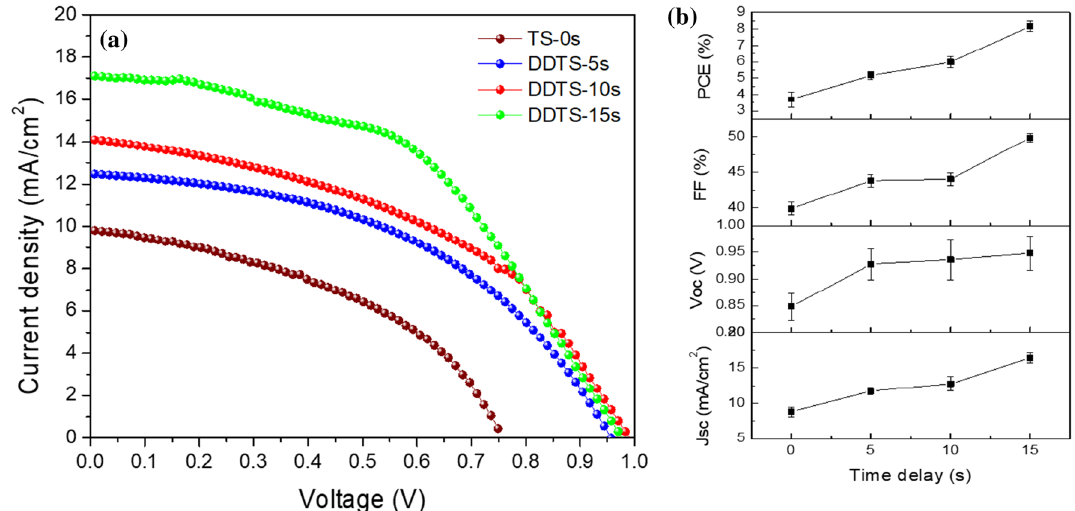
Fig. 6 a Photocurrent density–voltage (J–V) curves of PSCs using perovskite regulated time delay (from 0 to 15 s). b Average and standard deviation of photovoltaic performance parameters of at least 5 samples (10